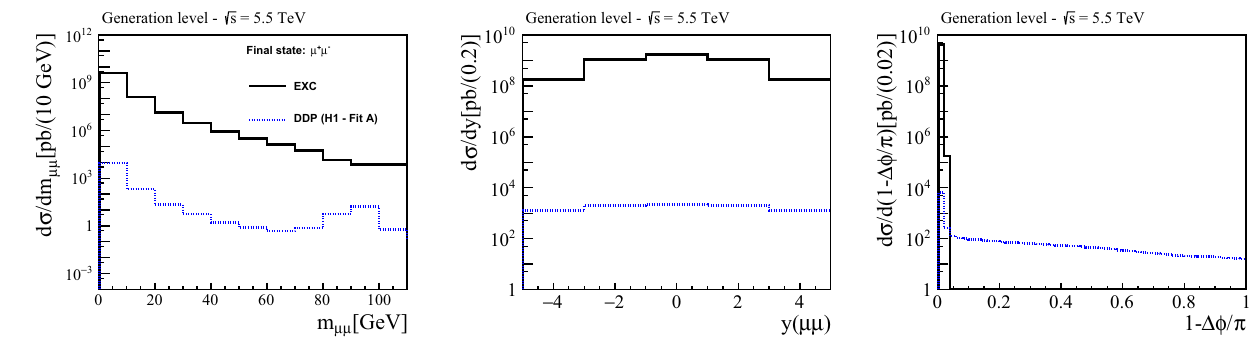
Fig. 2 Results for the invariant mass m μμ , rapidity y (μμ) and acoplanarity distributions of the μ + μ − pair at generation level for in PbPb collisions at the LHC Table 1 Predictions for the dielectron and dimuon production at forward rapidities √ s = 5 . in PbPb collisions at